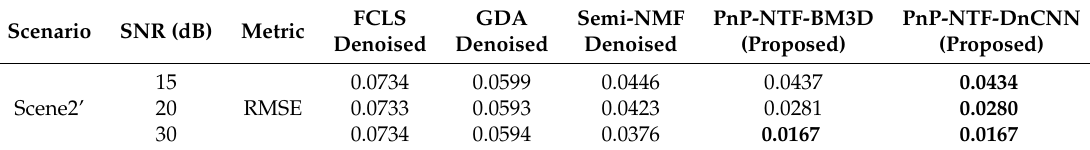
Table 5. Evaluation result of denoised abundance in ’Scene2’ with different SNRs.